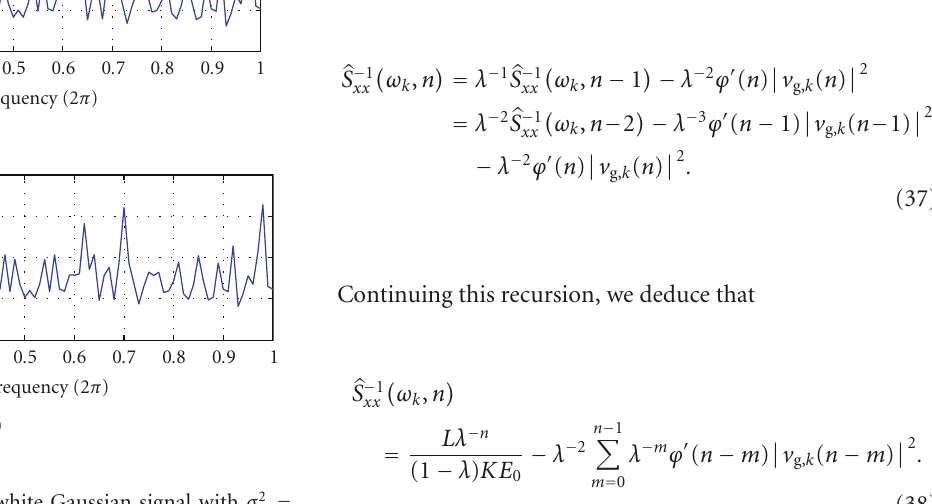
Figure 2: Inverse spectrum of a white Gaussian signal with σ 2 x = 1, L = K = 100, λ = 1 − 1 / (5 L ), and N = 1000. (a) Recursive algorithm. (b) Fast recursive